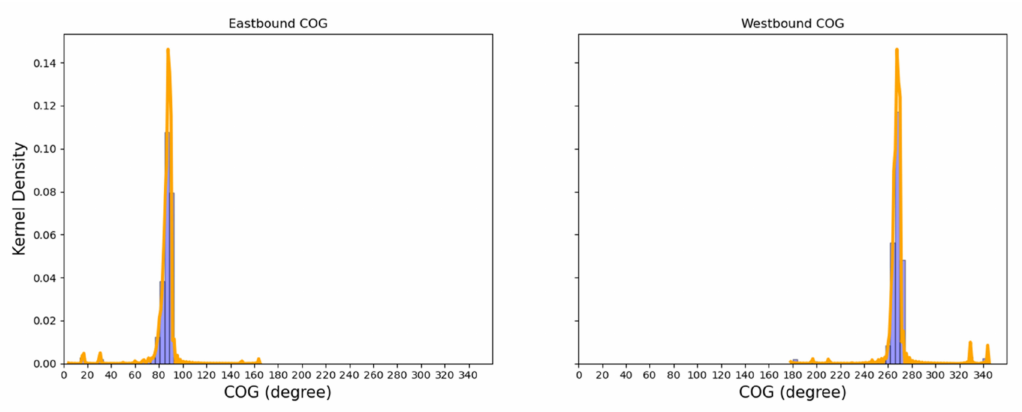
Figure 10. Histogram and PDF for COG in the selected cell.